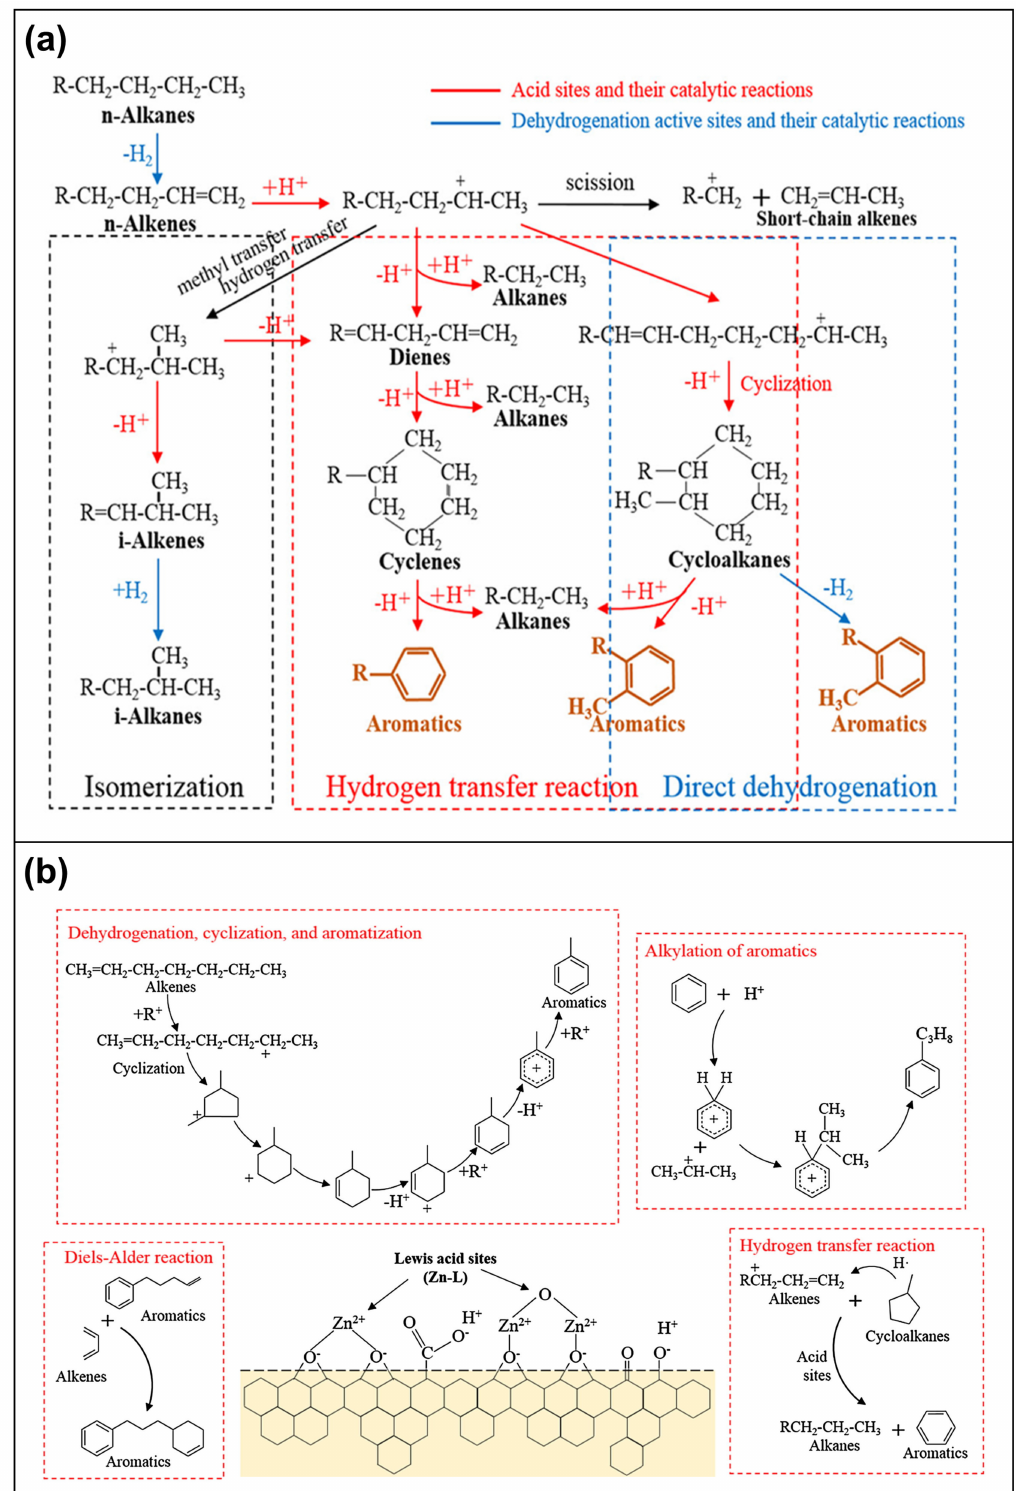
Figure 6. Catalytic mechanism of plastic with ( a ) H 3 PO 4 -AC [124] and ( b ) ZnCl 2 -AC